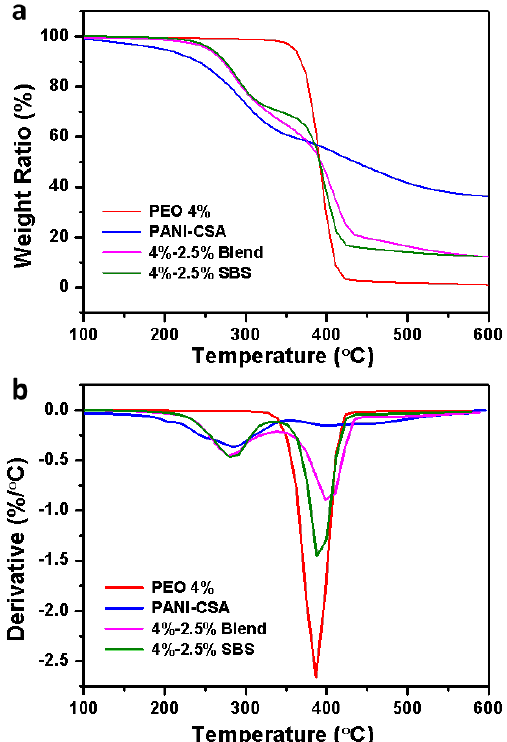
Figure 6. ( a ) Thermogravimetric analysis (TGA) and ( b ) derivative thermogravimetry (DTG) curves of neat PEO, PANI-CSA, blend and side-by-side PEO-PANI fibers (4%–2.5%).